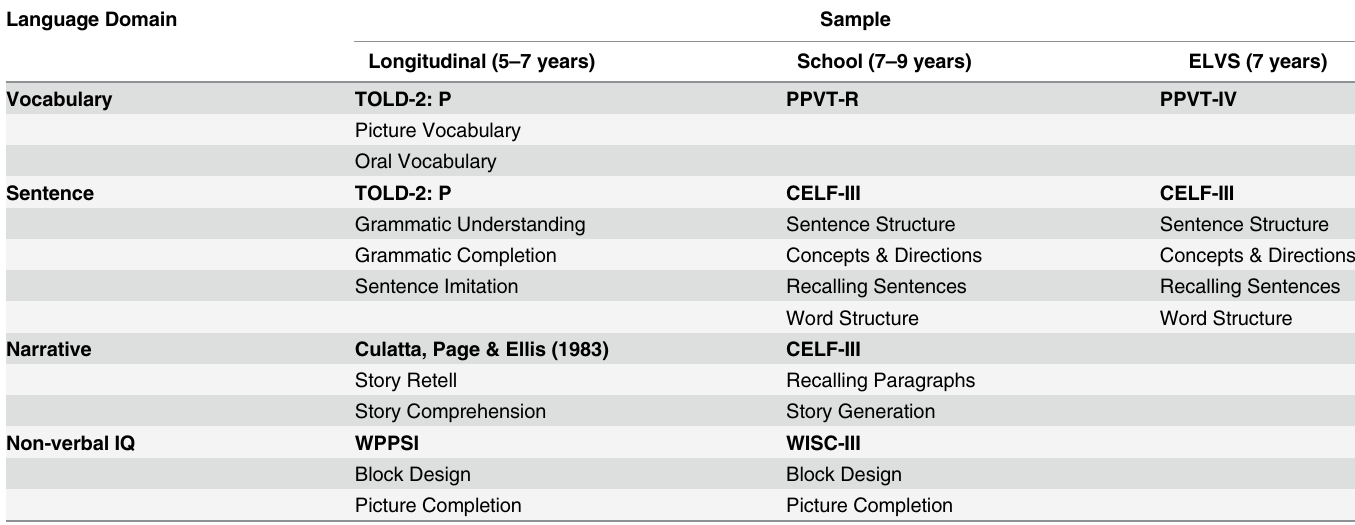
Table 3. Language measures in each